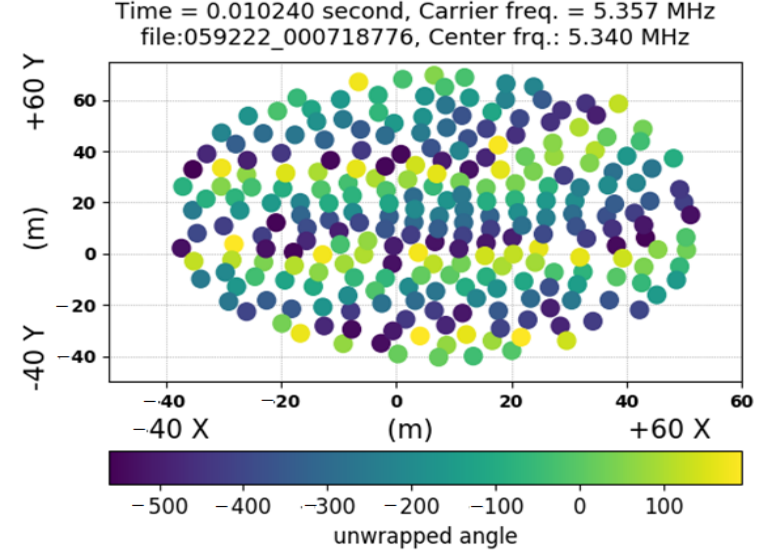
Figure 8. Phase image of antenna locations applying the relative unwrapped phase.